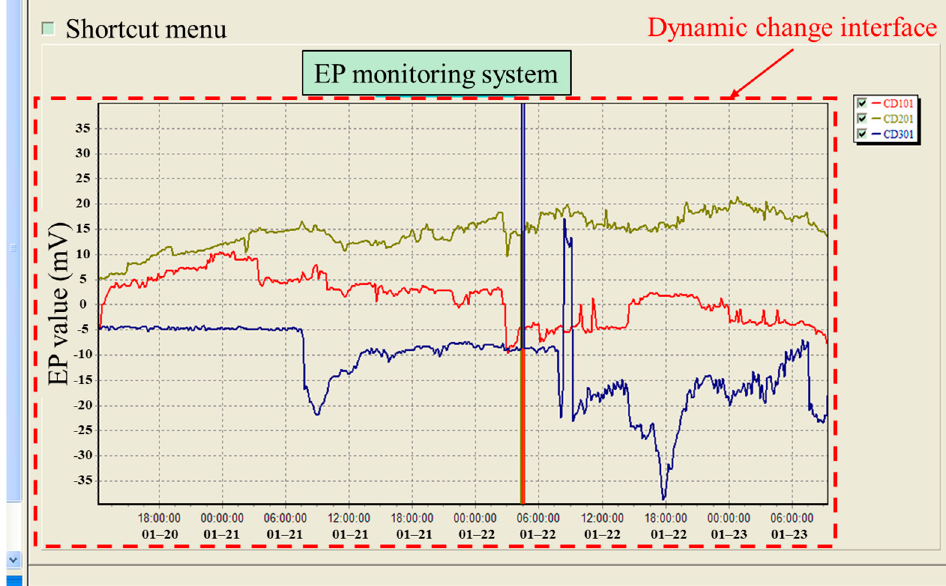
Figure 3. EP analysis software.